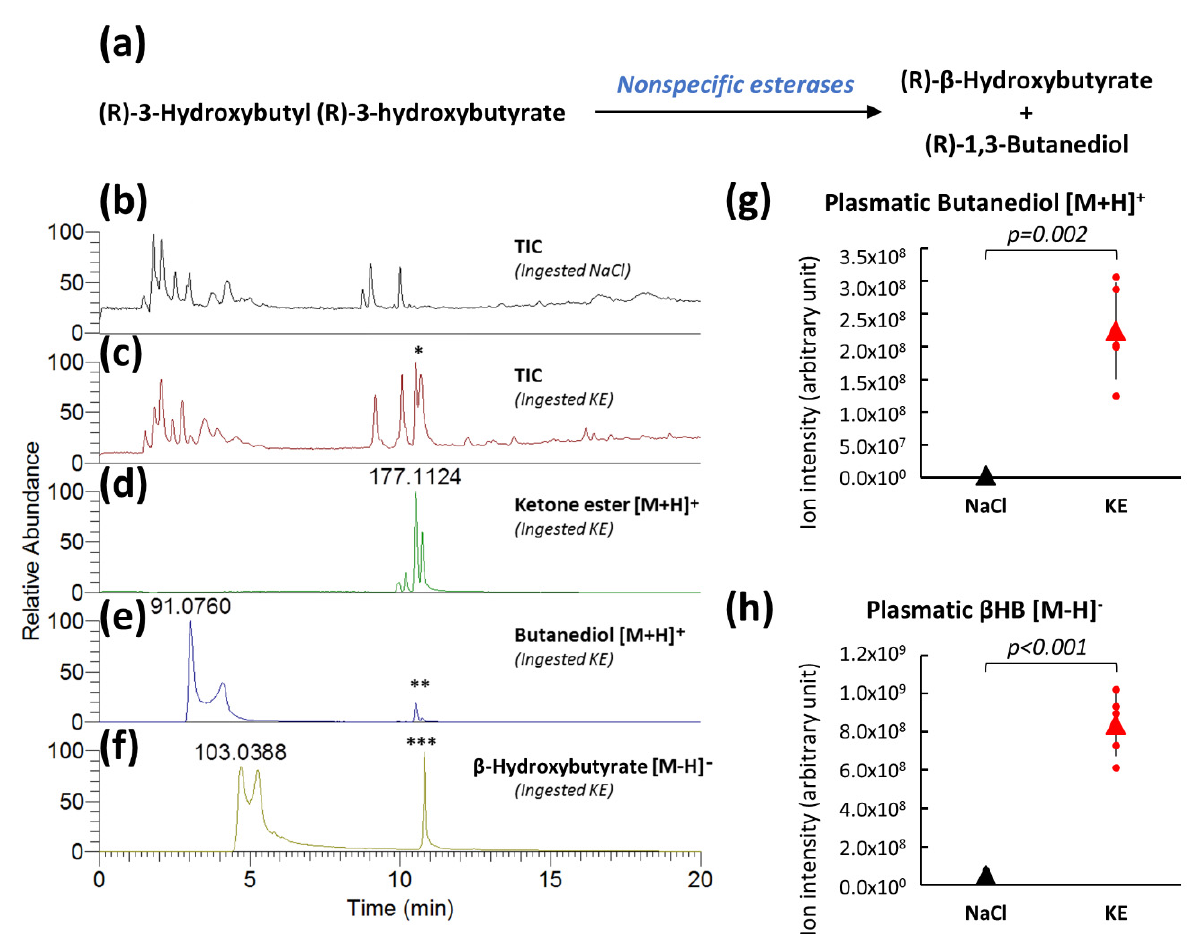
Figure 1. Plasma analyses after KE ingestion. Plasma β -hydroxybutyrate ( β HB)and 1,3-butanediol levels ( a ). Total ion LC-MS chromatograms (TIC) acquired in positive spectrometry mode of plasma samples from 0.9% NaCl-gavaged control mice ( b ) from KE-gavaged mice (3 mg KE/g of body weight) ( c ) (* KE peak on the TIC chromatogram). Extracted ion chromatograms of KE ( d ) and its metabolites butanediol ( e ) and β -hydroxybutyrate ( f ) from plasma of KE-gavaged mice (in electrospray ionization source produced butanediol from KE (**) and β -hydroxybutyrate from KE (***). Levels of KE metabolites (butanediol [M+H] + ( g ) and β -hydroxybutyrate [M − H] − ( h )) from the plasma of mice 30 min after NaCl or KE gavage (n = 5).